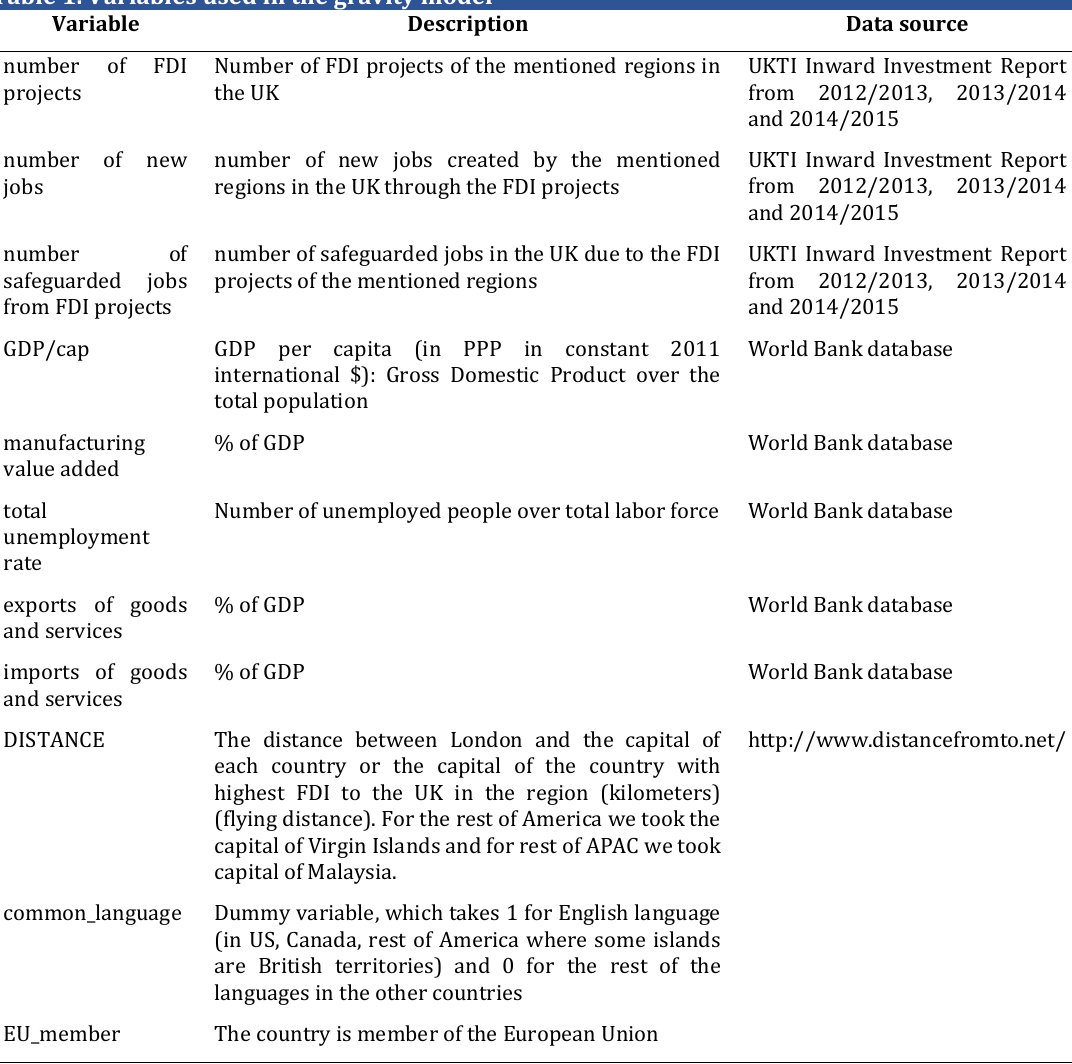
Table 1. Variables used in the gravity model